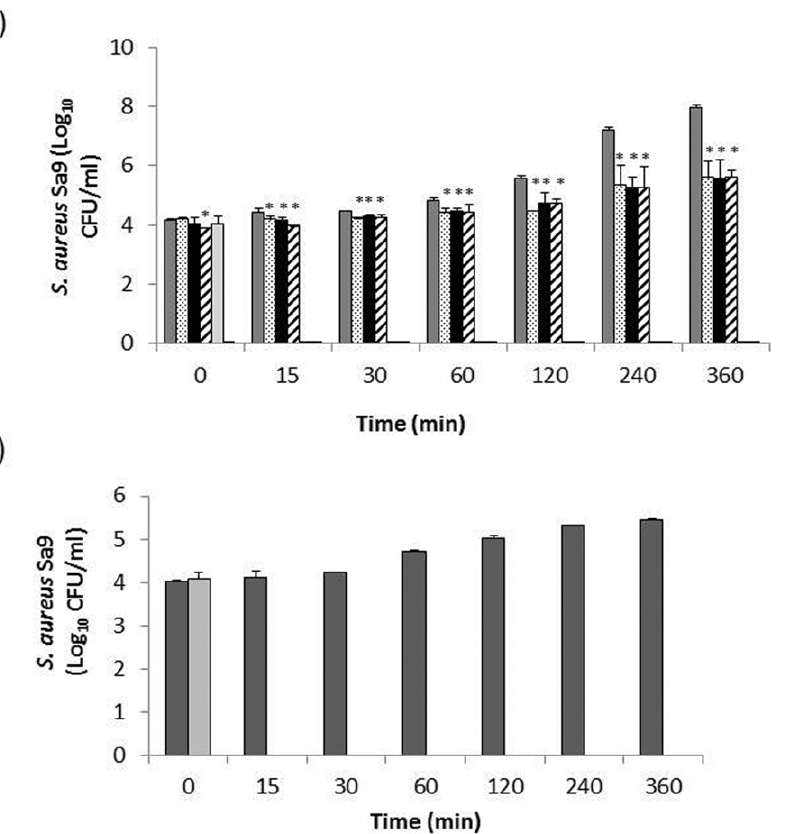
Figure 1. Antimicrobial activity of HydH5, lysostaphin, and its derivative fusion proteins in commercial whole ELS milk. Milk was inoculated with 10 4 CFU/ml of S. aureus Sa9 and incubated for 0, 15, 30 min, 1, 2, 4 and 6 h at 37 u C either without lytic protein (control; dark grey bars) or in the presence of : A) 1 m M CHAP-SH3b (light grey bars), and 3.5 m M HydH5 (stippled bars), 3.5 m M HydH5SH3b (black bars) and 3.5 m M HydH5Lyso (diagonal stripes bars); 1 m M lysostaphin (gross line on X axis); (B) 1.65 m M CHAPSH3b (light grey bars), control without protein (dark grey bars), at room temperature. Values expressed as log 10 CFU/ml are the means 6 standard deviations of two independent experiments. Bars having an asterisk are significantly different from the control (* P # 0.05). S. aureus detection threshold ( , 10 CFU/ml).